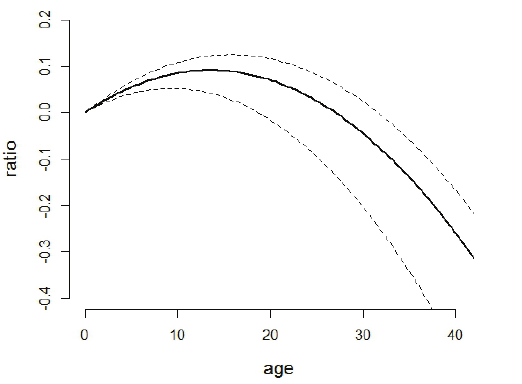
Figure 8. Fixed eff ect of property age Solid line denotes the median value, and the upper and lower dotted lines indicate 2.5th percentile and 97.5th percentile values,